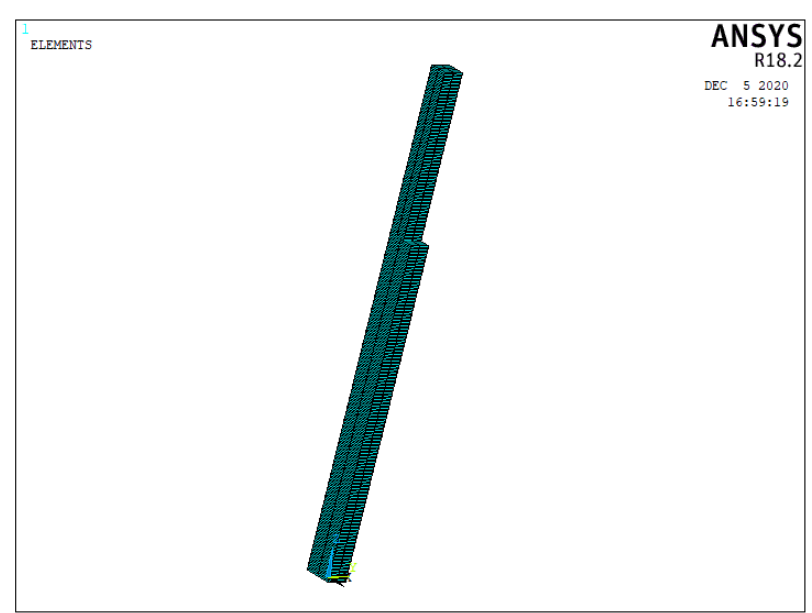
Figure 7. Grid division of the rectangular section.